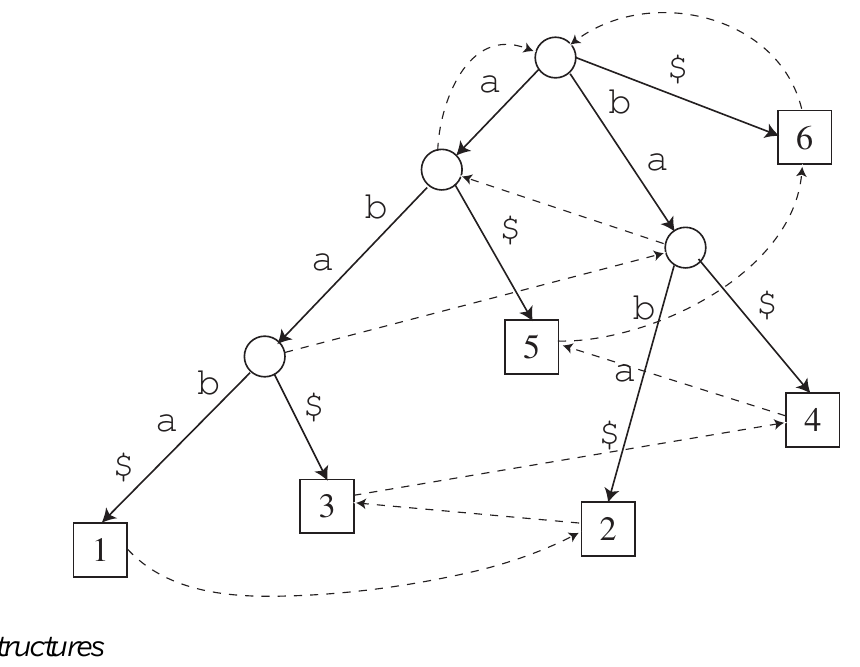
Figure 1. STree ( w ) with w = ababa $ . Solid arrows represent edges, and dotted arrows are suffix